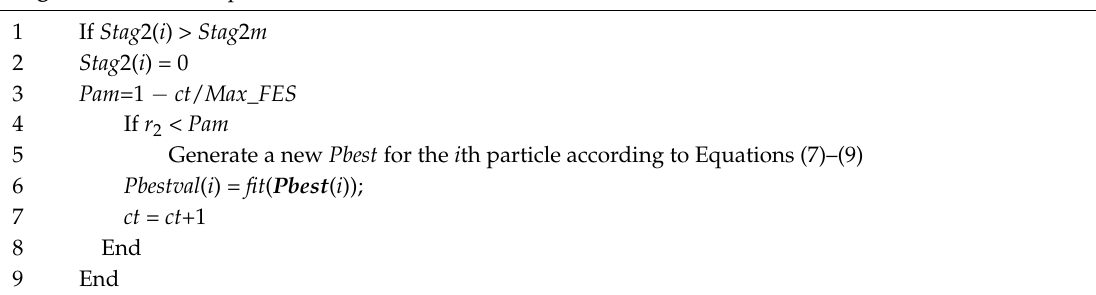
Algorithm 2. The adaptive mutation